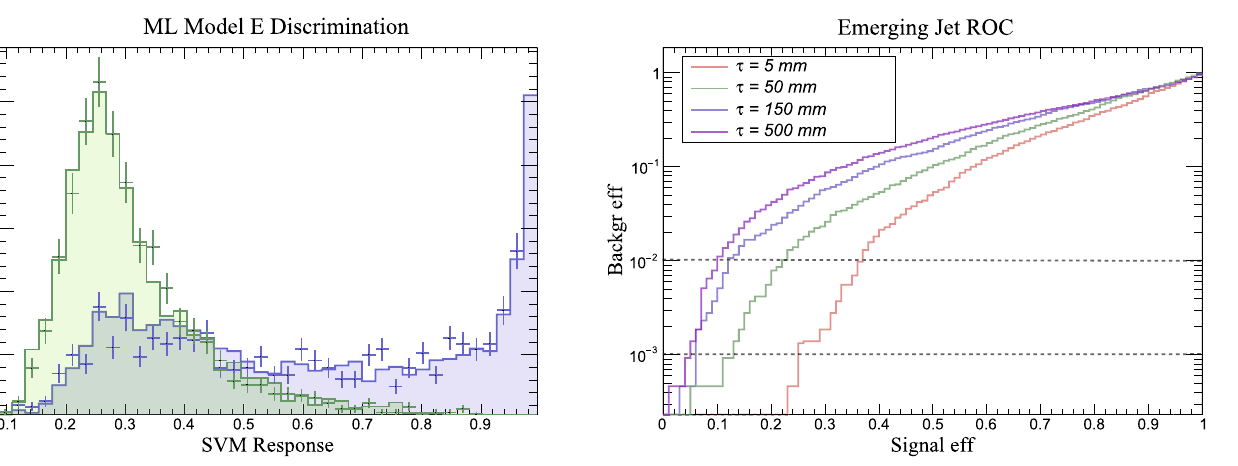
signal. At a given background efficiency, the expected signal efficien- cies increase as the dark pion lifetimes lower. The required background rejection is estimated to lie between the horizontal dotted lines. Both figures use a mediator mass of 500